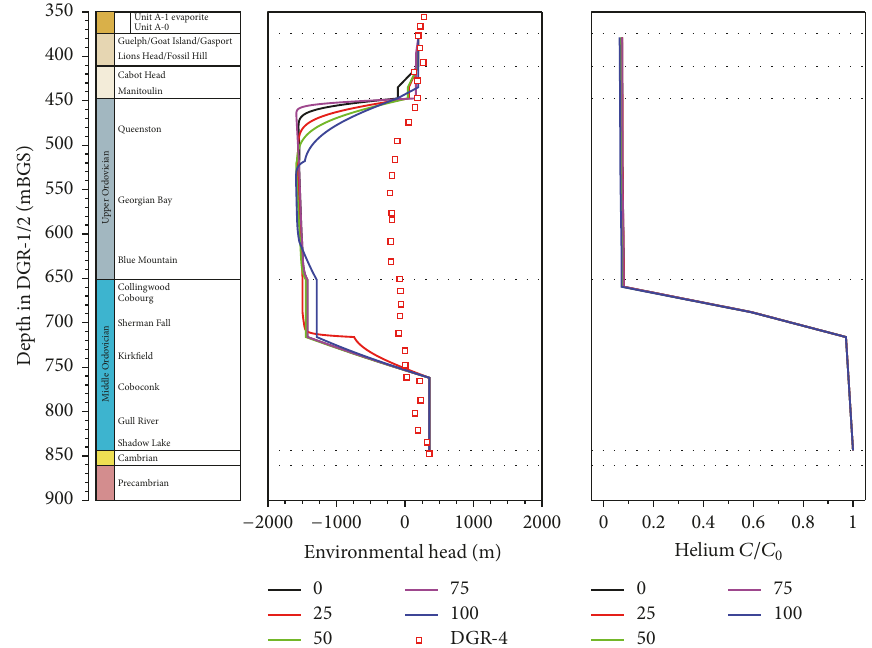
Figure 12: Simulation of helium unit tracer over 260Ma using calibrated vertical hydraulic conductivities for glaciation scenario nn9930 for calibrations using present day environmental heads as the initial condition. Coloured lines represent different percentages of ice-sheet thickness applied as excess head to the top boundary